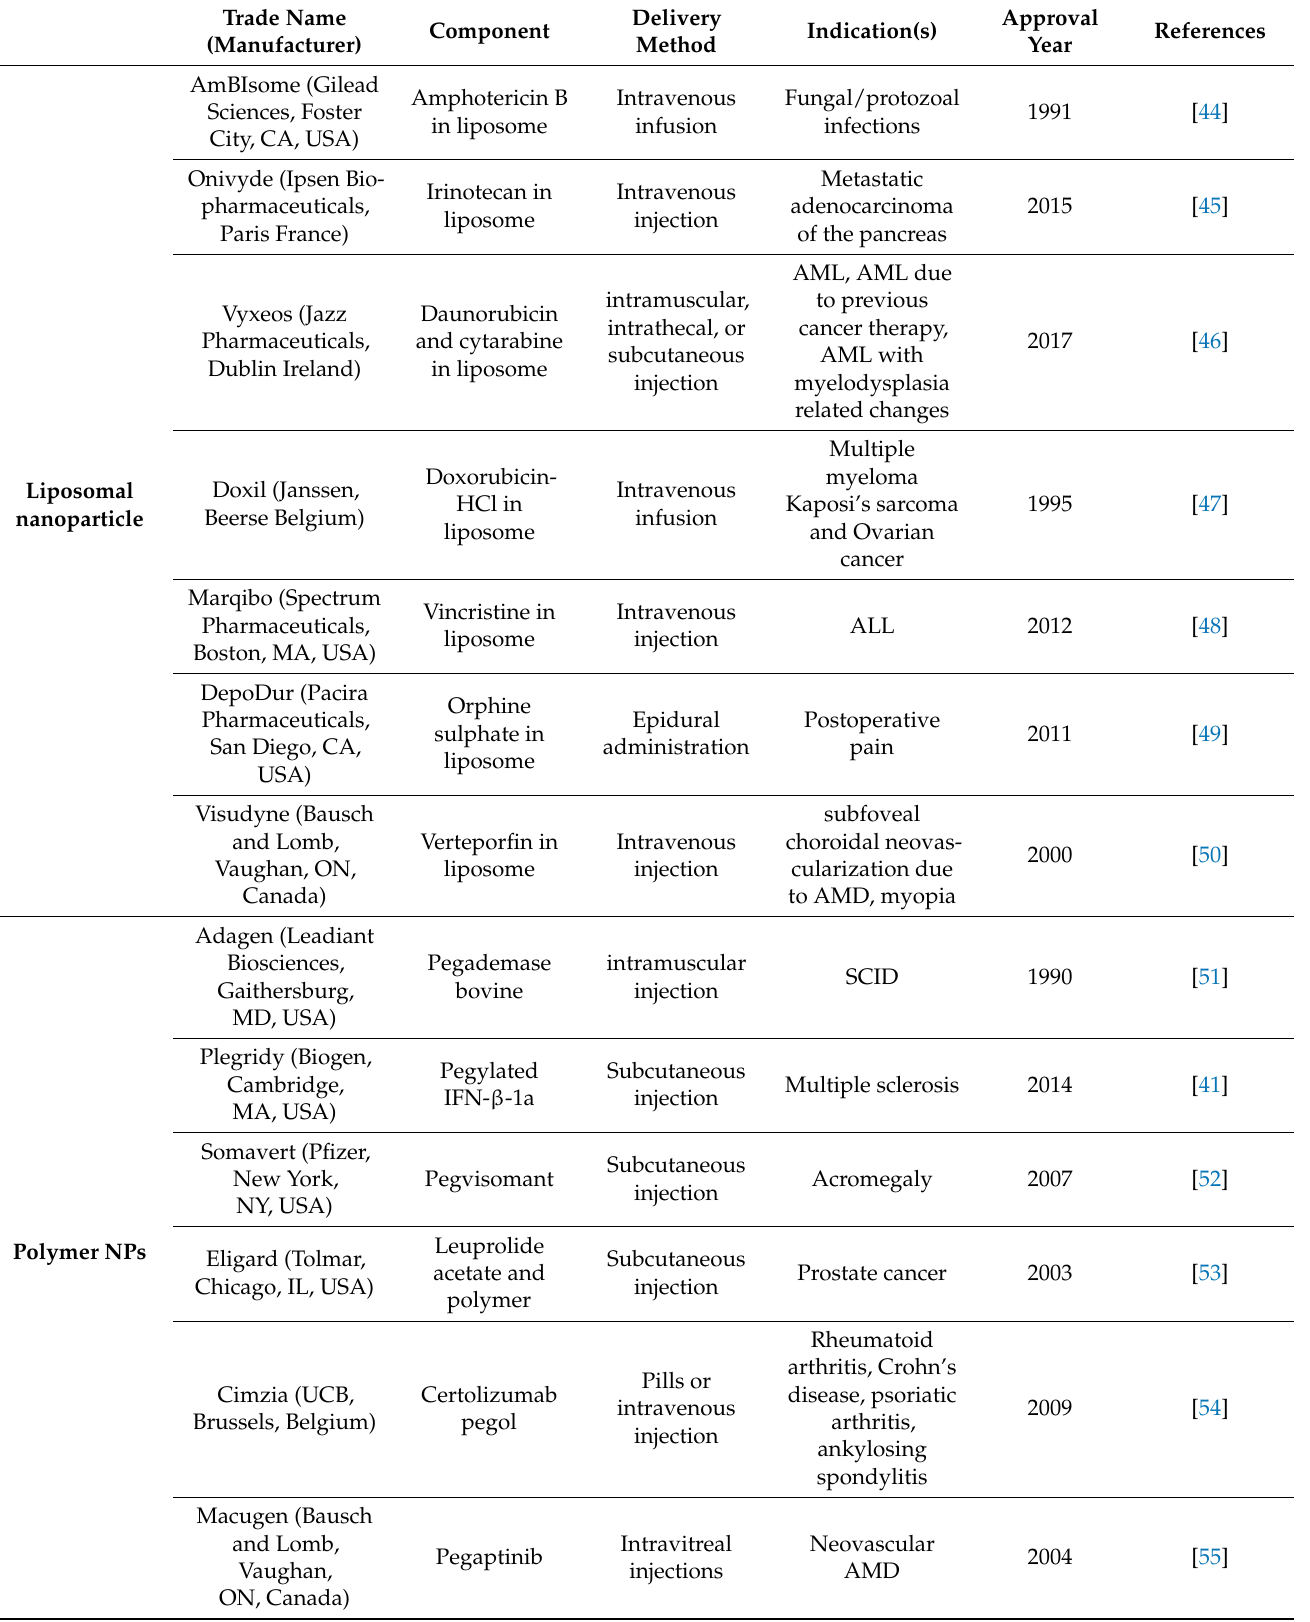
Table 1. List of nanodrugs approved by the FDA for clinical application